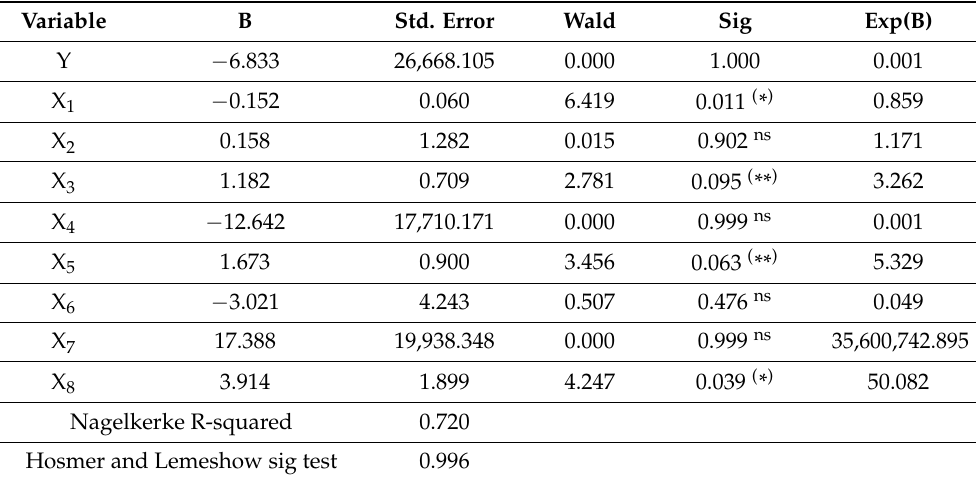
Table 2. Determinants of consumers’ use of an information source in the local agricultural market in